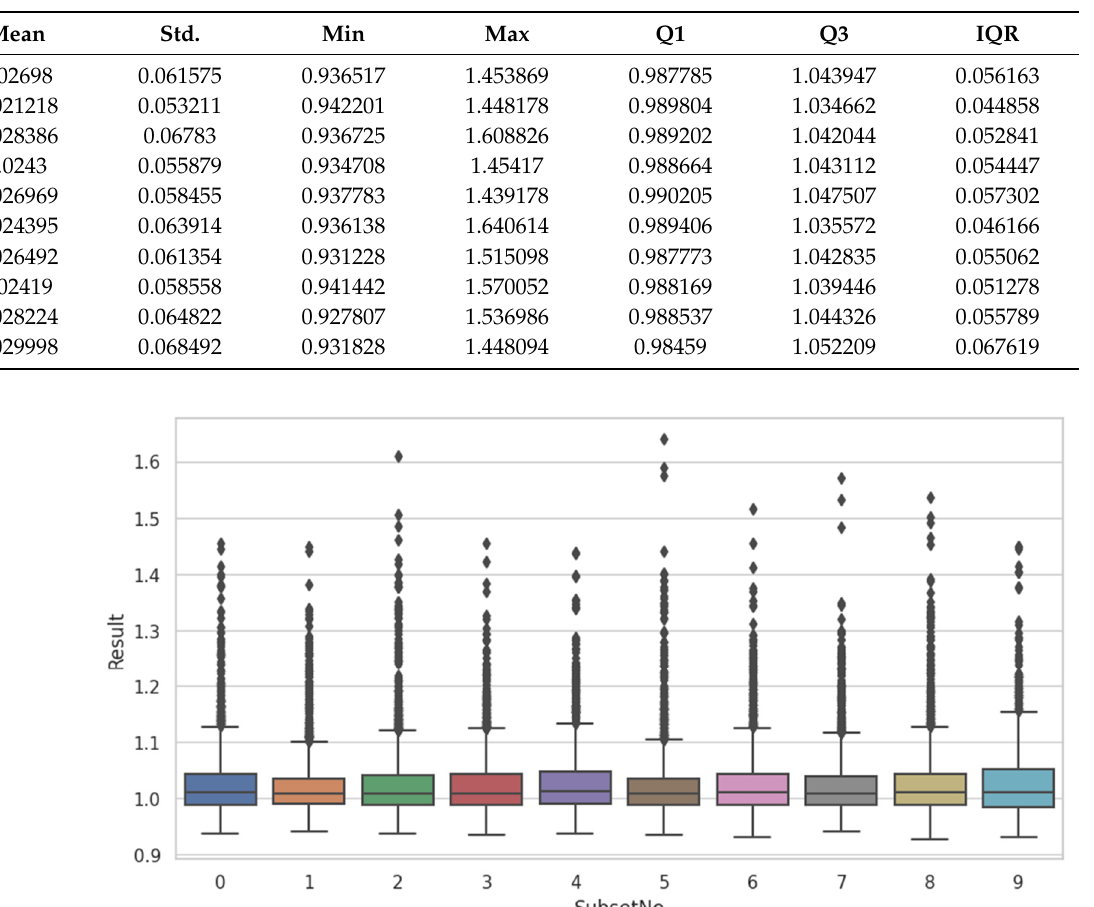
Table 6. Descriptive statistics for keywords of subsets.